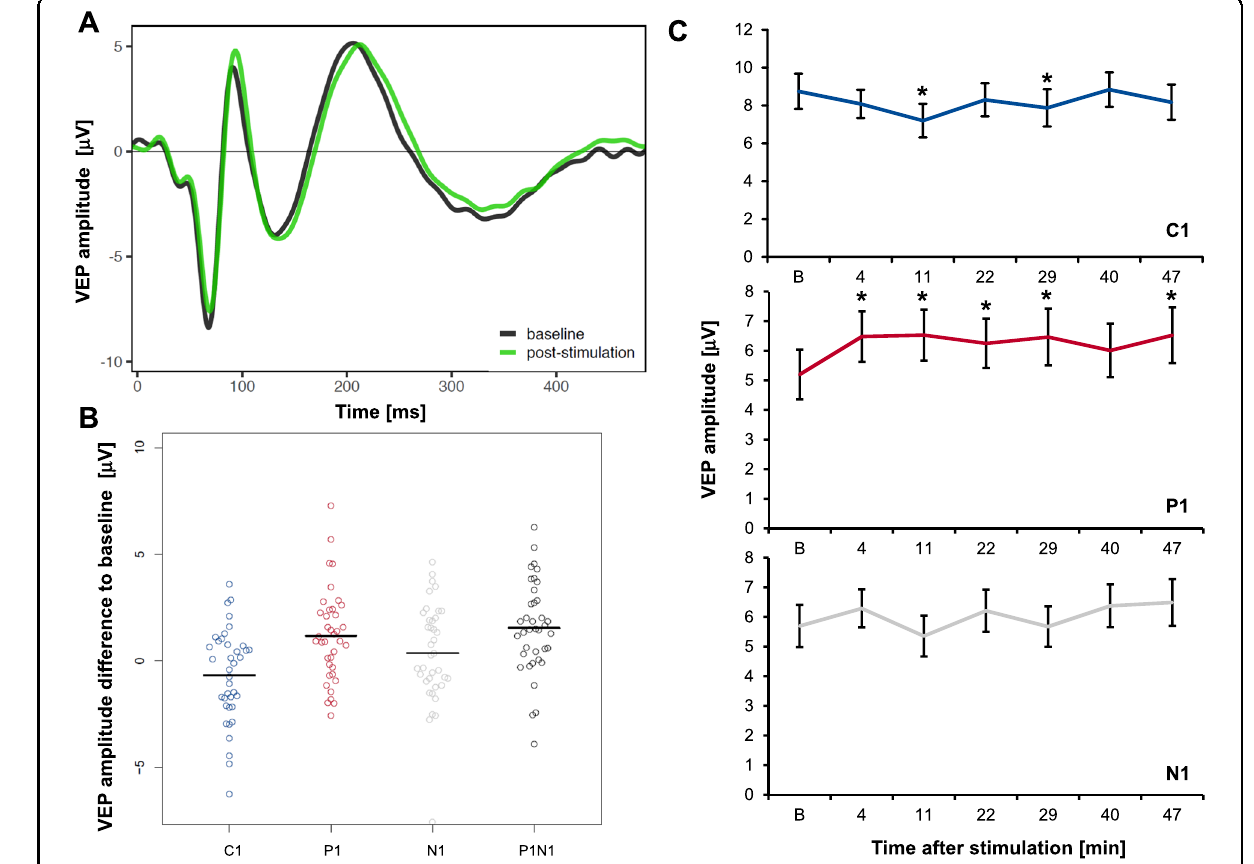
Fig. 3 Prolonged visual stimulation induced VEP plasticity ( n = 38, PVS + /tDCS − ). A Checkerboard reversal VEP traces before (black) and averaged poststimulation VEPs (green) after the presentation of a 10-min checkerboard reversal stimulation block. B Change in peak VEP amplitudes averaged after stimulation compared to baseline (horizontal line, mean). P1 and P1N1 increased signi fi cantly. C Mean peak amplitudes of C1, P1, and N1 VEP components over time + / − SE. Asterisk indicates signi fi cant post hoc contrast of baseline peak amplitude [B] compared to test peak amplitude. VEP visually evoked potential, PVS prolonged visual stimulation, tDCS transcranial direct current